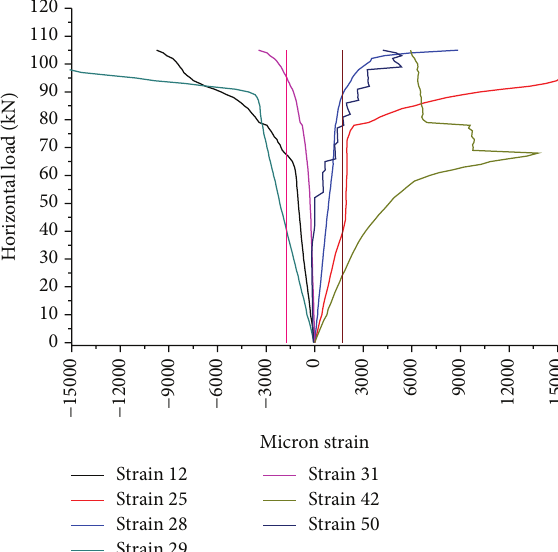
Figure 21: Load-strain